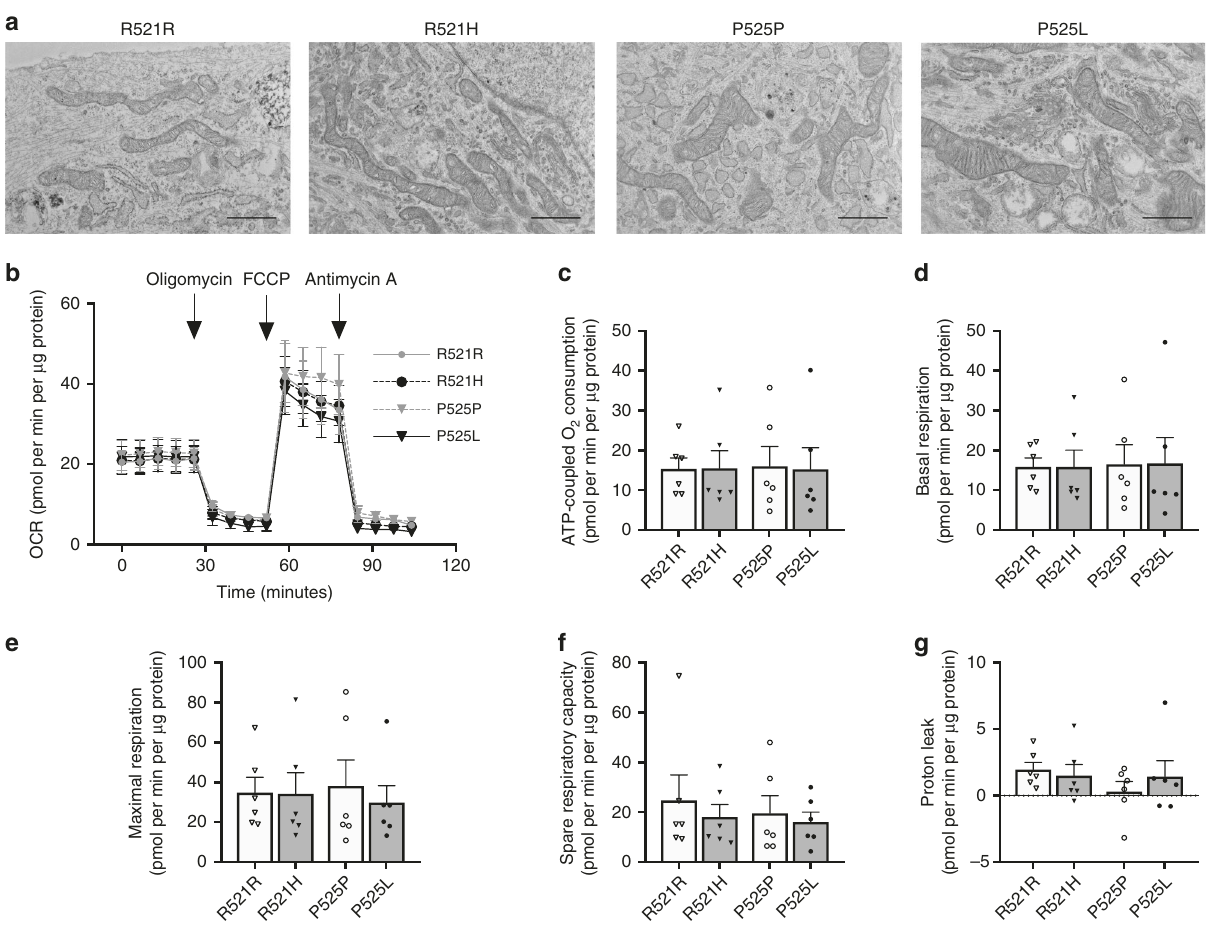
Fig. 4 Mitochondrial morphology and respiration in MNs derived from FUS – ALS patients and isogenic controls. a Representative transmission electron microscope (TEM) images of the mitochondria from patient (R521H, P525L) and isogenic control (R521R, P525P) motor neurons from three independent experiments. TEM operated at 80 kV at ×10.000 magni fi cation. Scale bar, 1 μ m. b Overview of the oxygen consumption rates (OCR) throughout the mitochondrial respiration test in patient and isogenic control motor neurons. Arrows indicate the time when mitochondrial inhibitors were added to the media to assess respiratory parameters. c ATP-coupled oxygen consumption was determined by inhibiting ATP synthase using oligomycin. d Basal respiration in patient and isogenic control motor neurons. e Maximal respiration was assessed following mitochondrial uncoupling by FCCP. f Spare respiratory capacity was determined by subtracting basal respiration from maximal respiration in patient and isogenic control motor neurons. g Proton leakage was determined after inhibiting complex III via antimycin-A. The data represent mean ± s.e.m. from six independent experiments, with individual data points shown. Statistical analyses in panel c – g were performed by one-way ANOVA with post hoc two-tailed t tests between cell lines ( p > 0.05). Dark grey bars indicate FUS-patient cell lines. Light grey bars indicate isogenic controls from these patients. Source data are provided as a source data fi